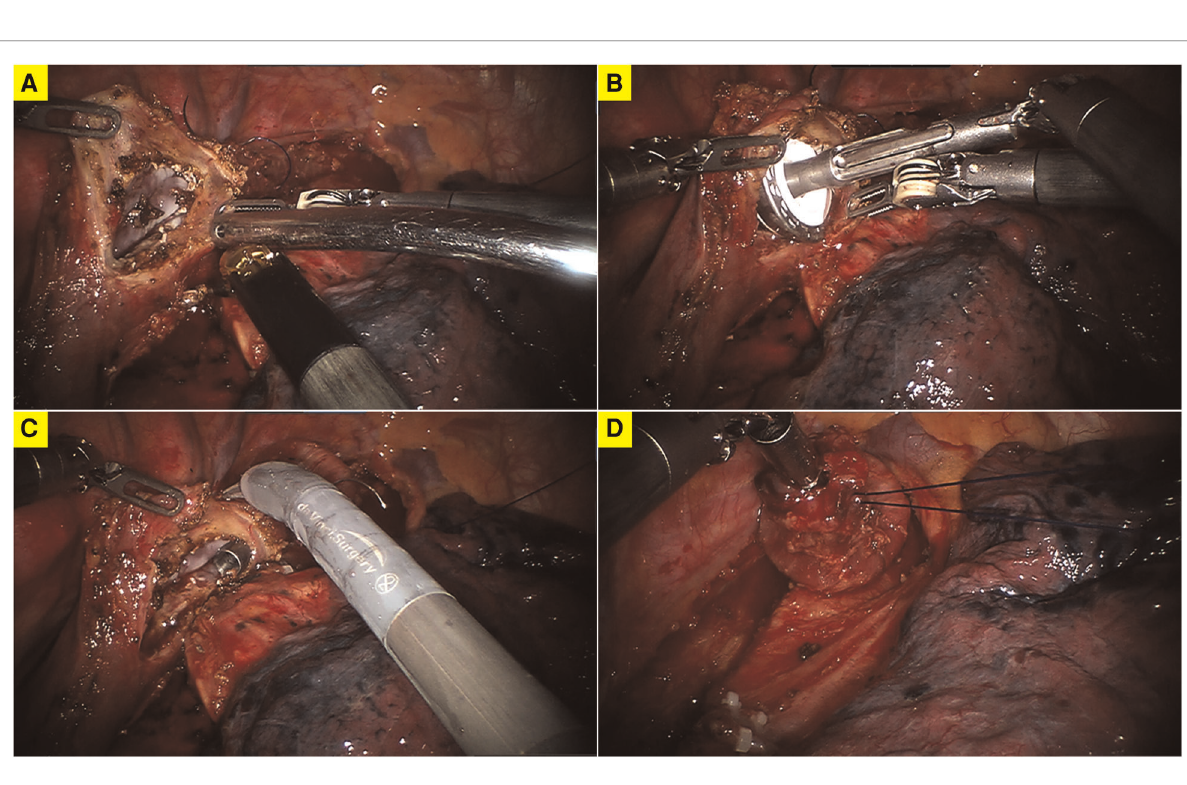
FIGURE 2 ( A ) A longitudinal incision at the anterior wall of the esophagus; ( B ) insertion of the anvil of a 25 mm stapler; ( C ) transection of the esophagus; ( D ) the fi xation of the